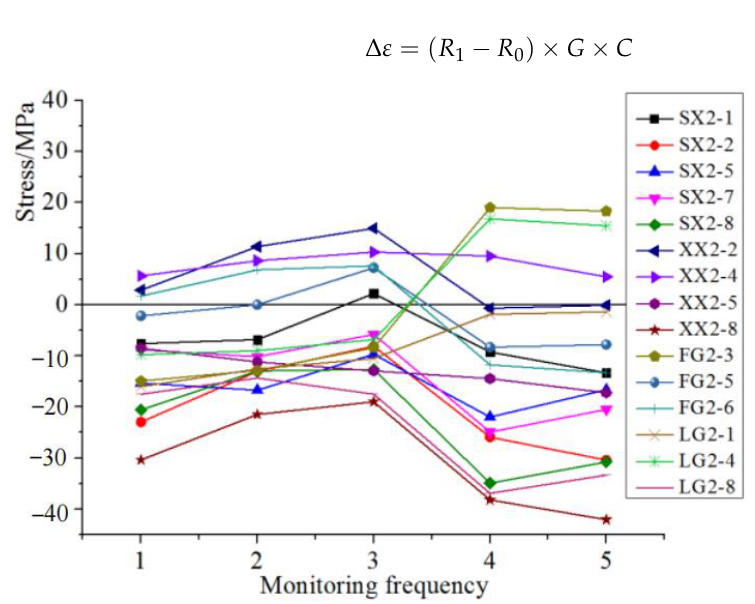
Figure 11. Measured stress curves.